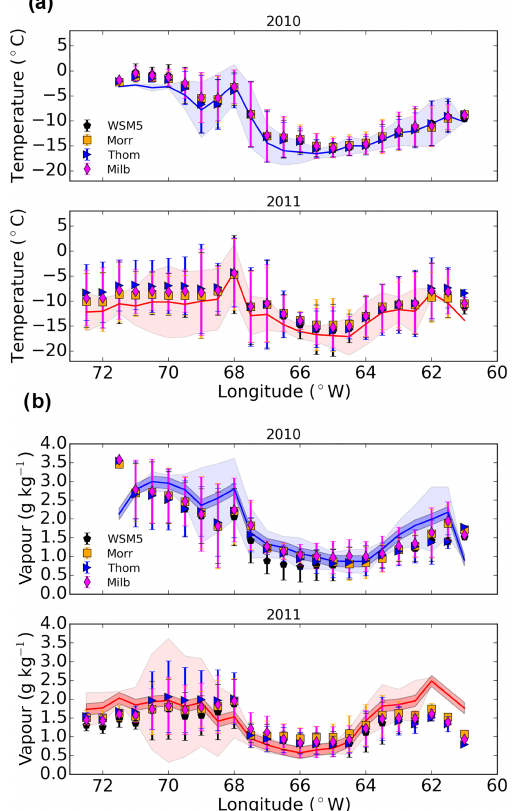
Figure 10. Zonal distribution for 2010 and 2011 flight campaigns of averaged (a) temperature and (b) water vapour (gkg − 1 ). Mea- surements are shown as a solid line, and simulations as markers. Shaded areas and error bars give the standard deviation in each 0.5 ◦ longitude bin for the observation and the simulations, respectively. The dark shaded area corresponds to a conservative estimate of the uncertainty on water vapour (see text for